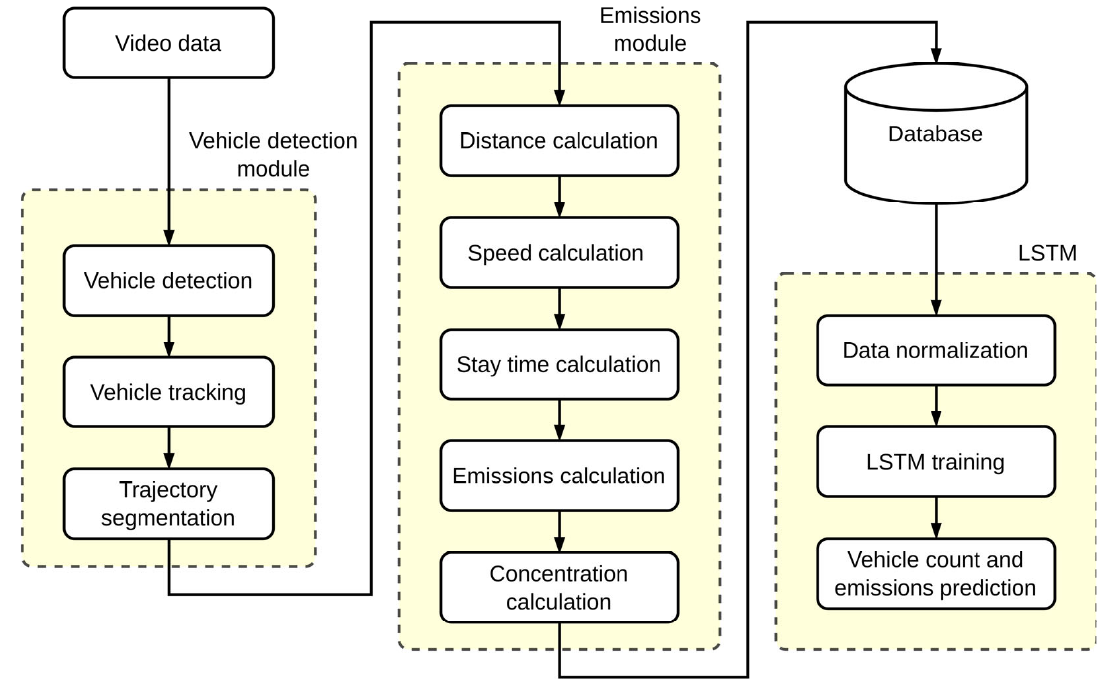
Figure 1. A flowchart of the developed program.